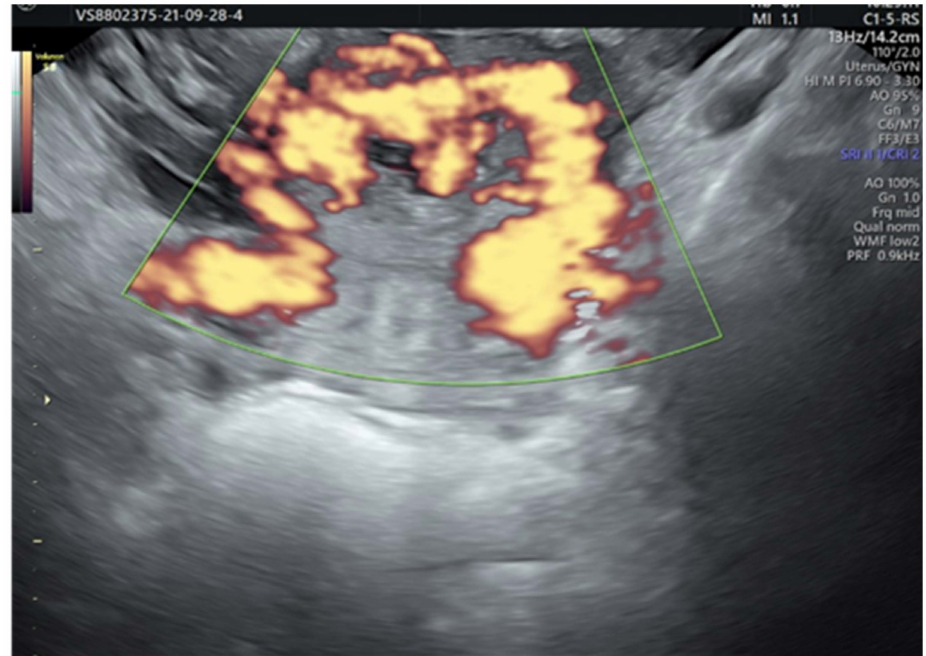
Figure 4. Intensely vascularized area; communication with the uterine